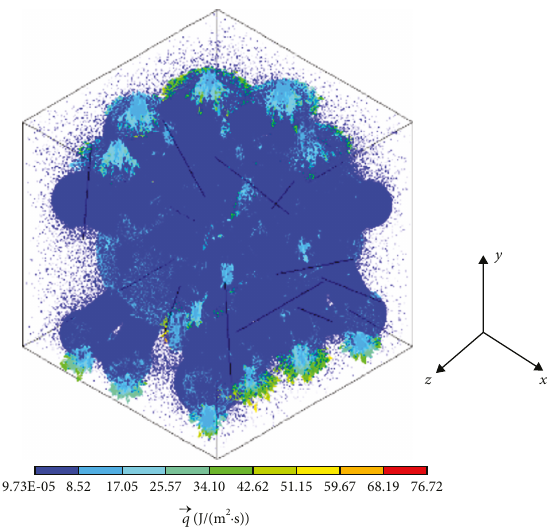
Figure 35: Temperature distribution of the fi nite element random model.